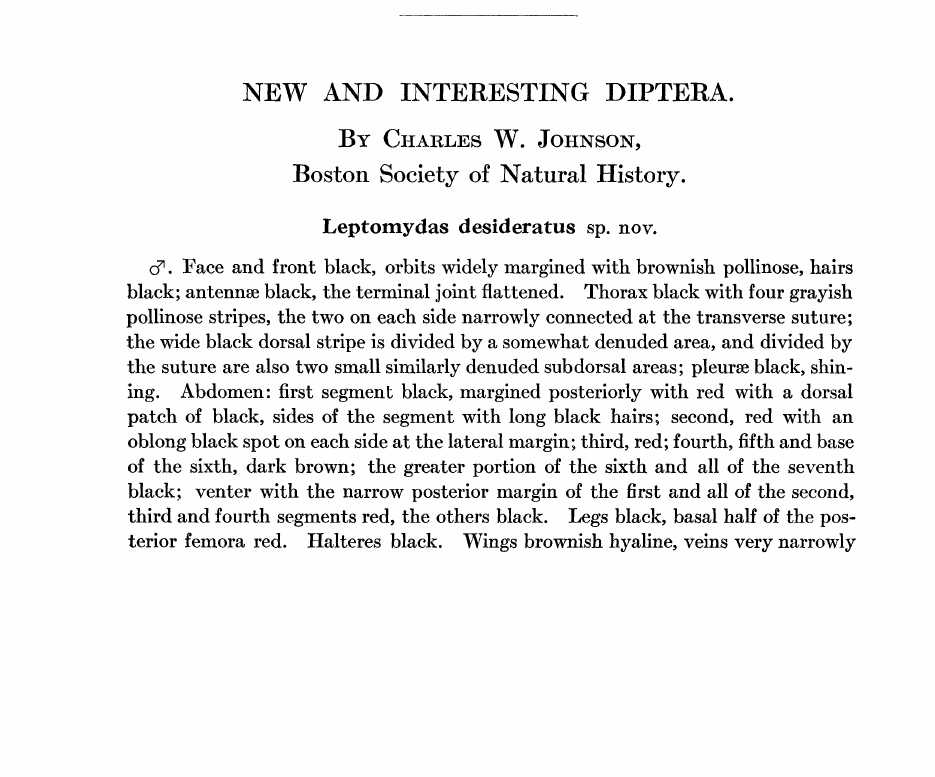
Color: 9 blood red tinged with yellow,, reflexed edges of pronotum and elytra somewhat darker, clothed throughout with a short, fine, whitish pubescence, ventral surface and legs yellowish red. Form broadly oval, convex. Head thicldy and finely punctured. Pronotum rather coarsely punctured, the punctures being dis- tinctly larger than those of the head. Elytra slightly more coarsely punctured than the pronotum, the punctures becoming a little deeper towards the sides. Ven- tral surface sparsely and finely punctured, the femora thickly and coarsely punc- tured, tibial spurs short and blunt. Length 3.1 mm. Width 2.5 ram. Type in my